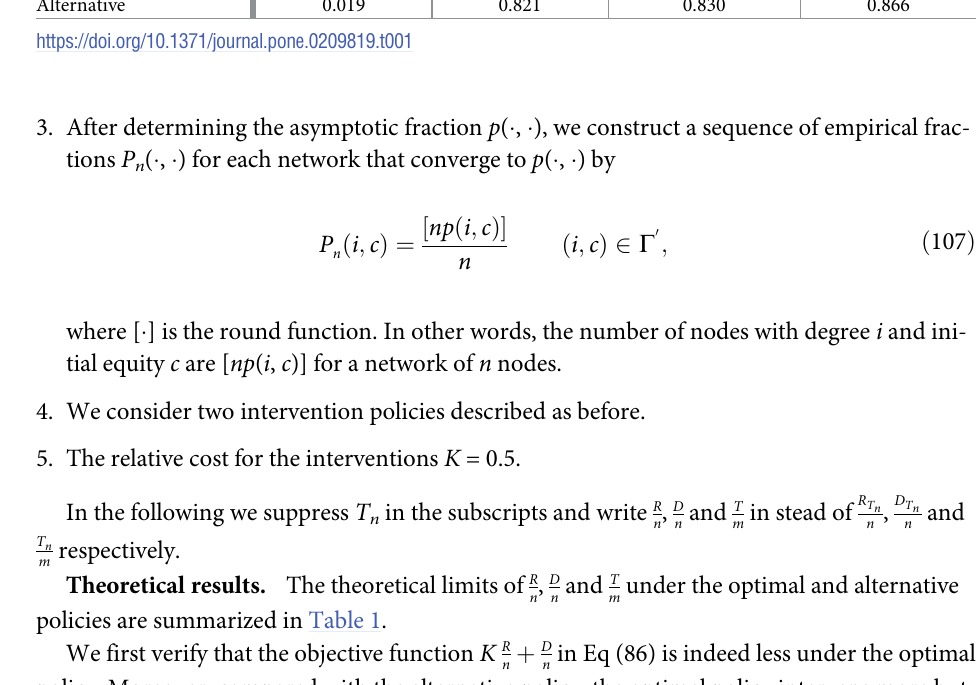
Table 1. Theoretical limits of R